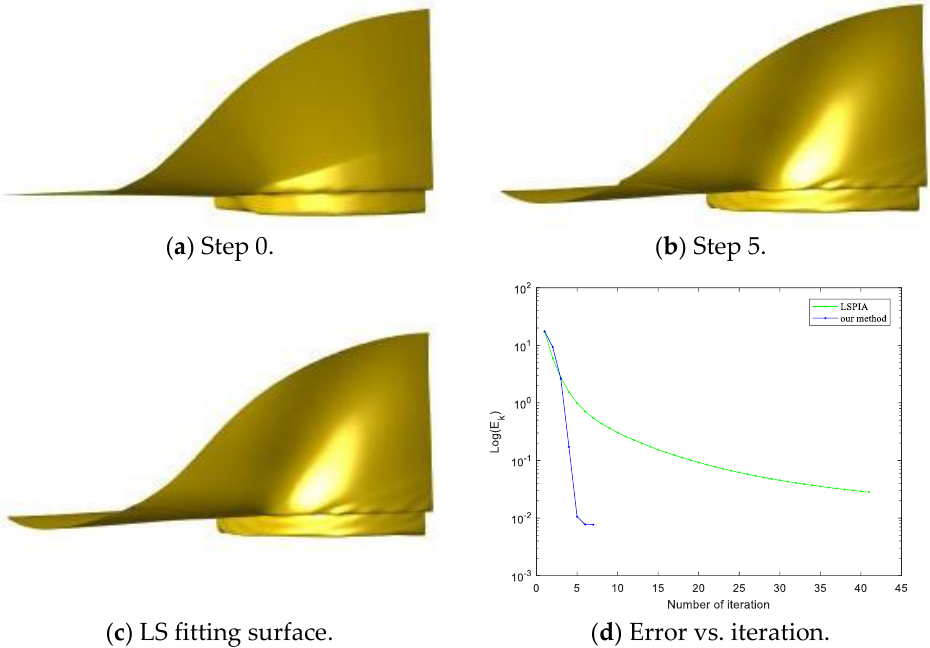
Figure 4. A data point grid with 41 × 61 points was fitted by a bi − cubic tensor product B − spline surface with 20 × 30 control points.